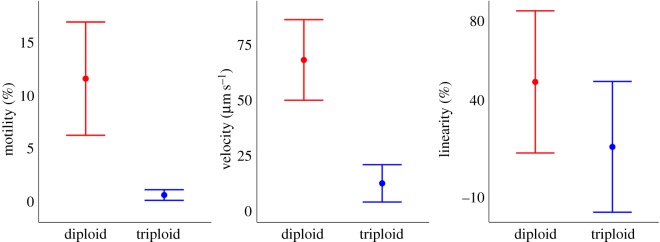
Interval plot of mean CASA measures (±s.e.) of sperm behaviour from 3-year-old male diploid (n = 10) and triploid (n = 10) Atlantic salmon.